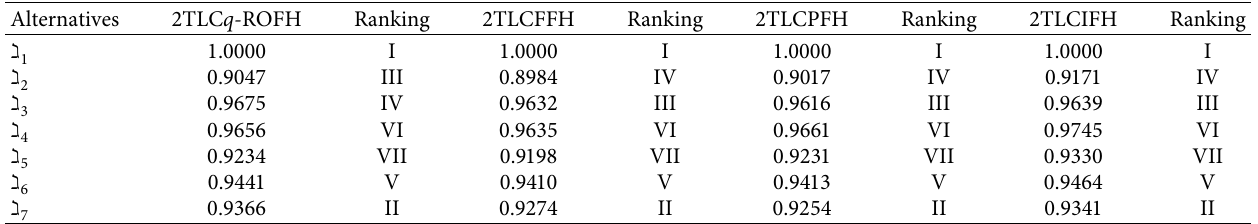
Table 18: Evaluation outcomes by utilizing different FSs based on the 2TLC q -ROFHWG